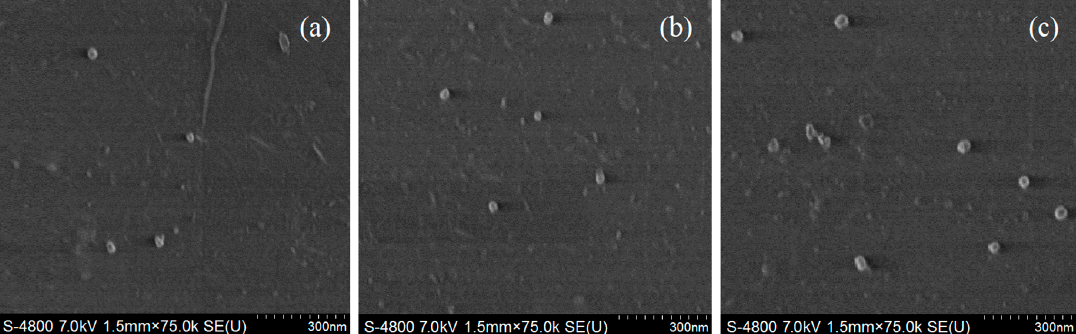
Figure 6. SEM cross-section images of ( a ) 0.5wt%TAIC- s -SiO 2 /XLPE, ( b ) 1.5wt%TAIC- s -SiO 2 /XLPE